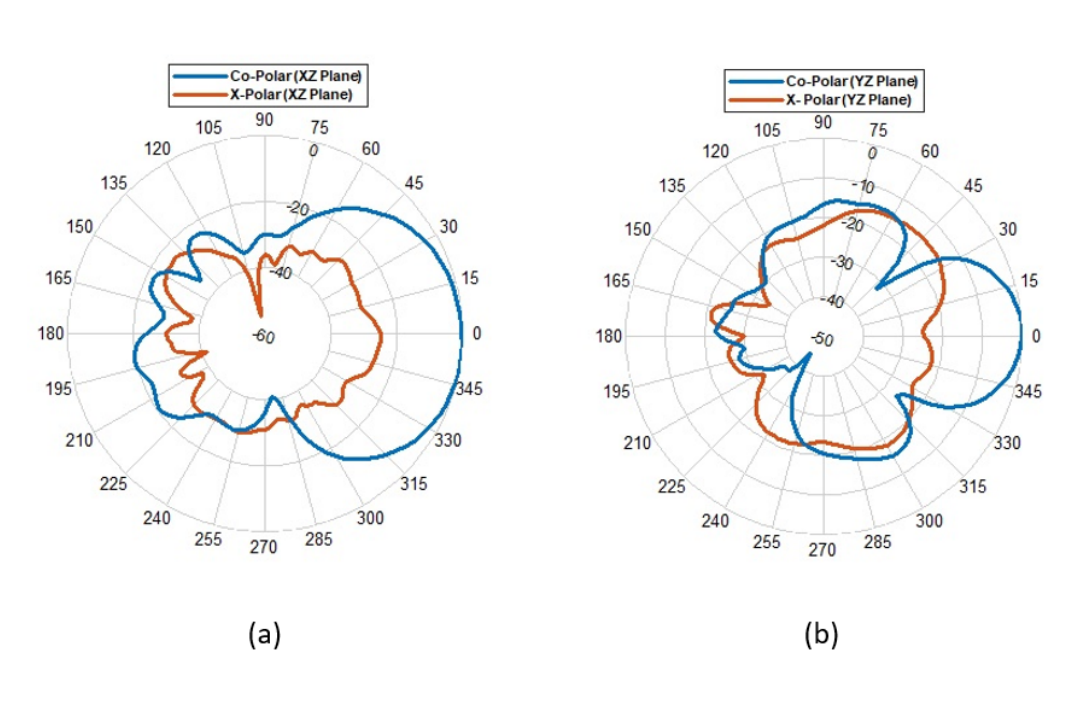
Figure 10. Measured MPAA patterns ( a ) φ = 0 ◦ , ( b ) φ = 90 ◦ . A single microstrip antenna (MPA) was used as the receiver. The simulated and measured patterns are depicted in Figure 11. The simulated realized gain was 2.9 dBi, and the measured gain was 2.7 dBi. The simulated and measured reflection coefficients ( | S 11 | ) are shown in Figure 12, which demonstrates a good performance at the resonant frequency of 2.4 GHz.